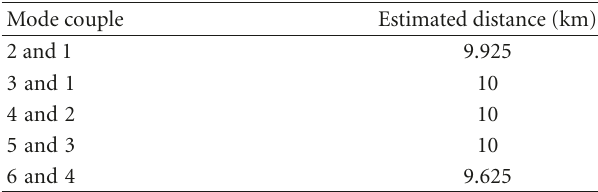
Figure 17: Contrast functions G for depth source localization by FT a approach with false mode sign estimation. The mode sign no. 3 is estimated with an error (estimated as negative, but should be positive). The configuration localization is the same as in Figure 16. Table 3: Results of the source distance estimation for FT a